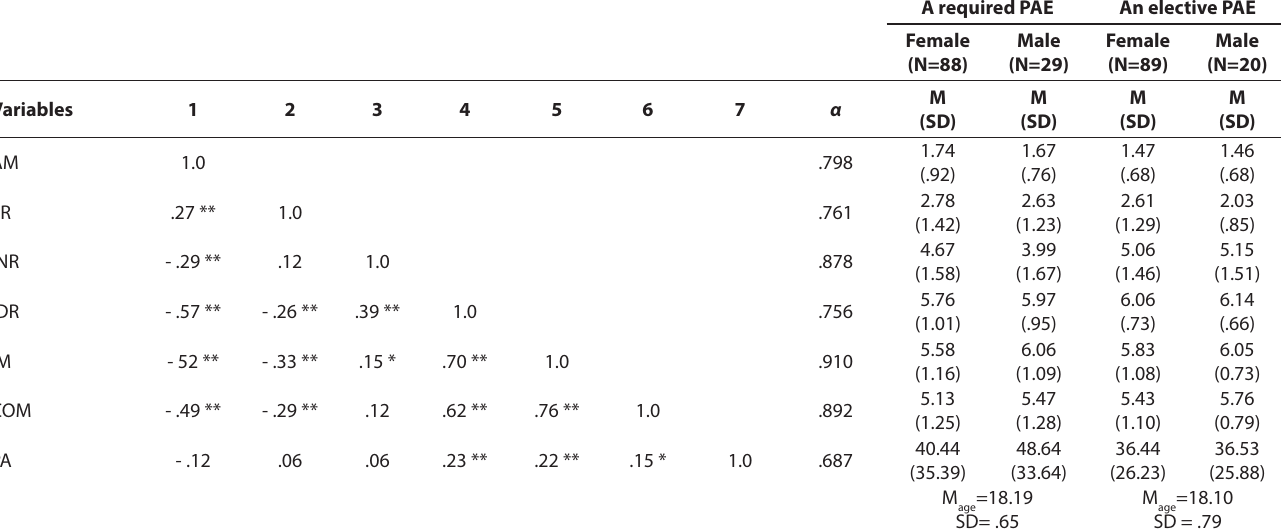
TABLE 1 Descriptive statistics, correlations, and reliability among variables (N =